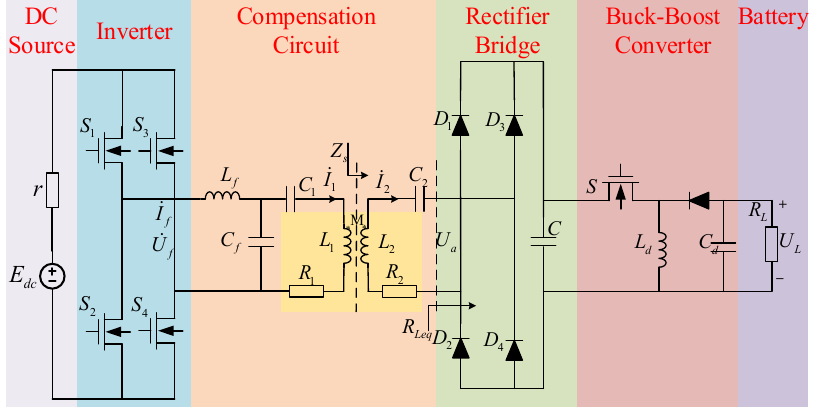
Figure 8. The wireless power transfer system with LCC-S compensation.